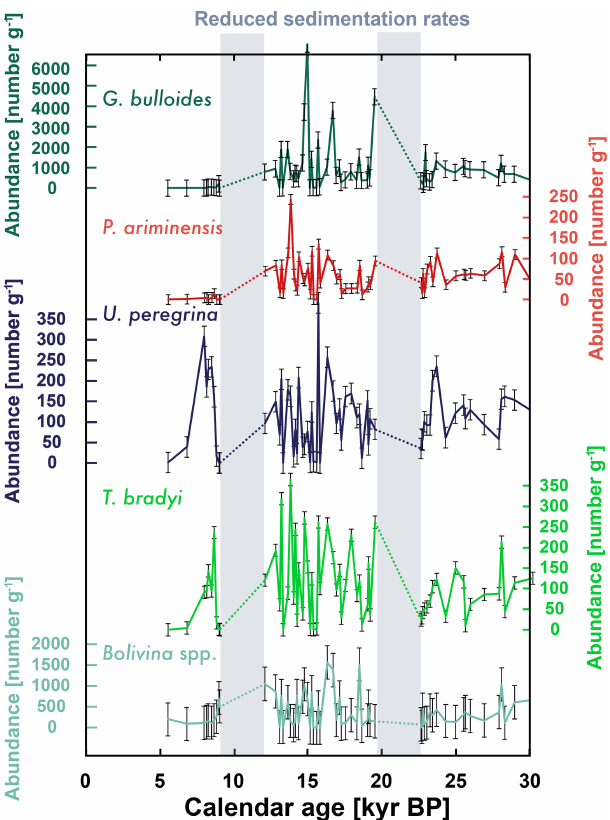
Figure 4. Foraminifera abundance at site LPAZ-21P for planktic ( G. bulloides ) and benthic species (all others). Error bars represent 2 times the typical standard deviation for replicate